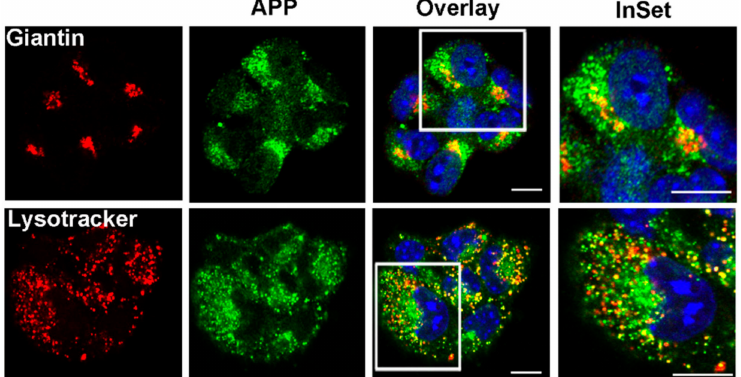
Figure 3. APP is localized in the Golgi apparatus and in the endolysosomal compartment. GT1 cells were grown on coverslips, fixed in PFA 4% and permeabilized in 0.1% TX-100 for 30 min, then they were stained with A8717 rabbit Ab (1:500) and Giantin (1:50) to label APP and Golgi, respectively. LysoTracker was used for 1 h in cell culture medium before fixation to label endolysosmes. Images are representative of at least 100 cells analysed. Scale bars, 10 µ